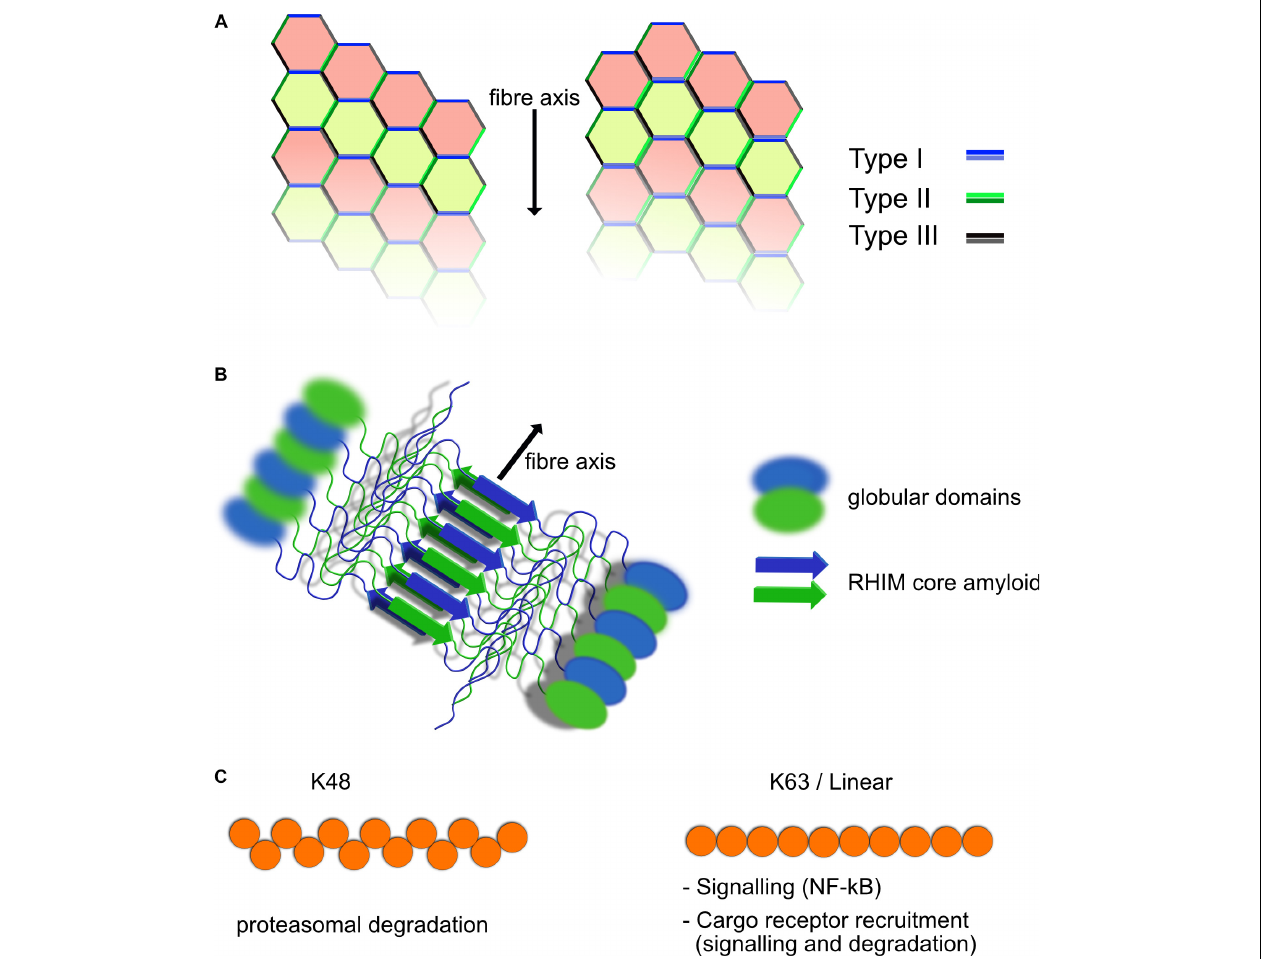
FIGURE 1 | Structural elements of death domain family, RHIM and ubiquitin scaffolds. (A) Death domain family interaction can form fibrillar structures. Death domain family members interact with themselves through three different interaction modes known as Types I–III, depending on the surfaces of the domain that interact. Shown are two possible helical fibrillar assemblies using differing combinations of interfaces. Multiple forms of this type of interaction have been identified, allowing for modular assembly of different complexes. (B) RHIM–RHIM scaffolds form amyloid fibrils. Shown is a fibril of two proteins containing a RHIM and globular domains. The fibril is formed by two parallel beta amyloid sheets coming together. This brings the globular domains into close proximity for interaction and potential activation such as kinase domains of RIPK1/3. RHIM fibrils can be mixed or homogeneous (RIPK1–RIPK3 or RIPK3–RIPK3 fibers form example). (C) Polyubiquitin chains have different functional roles. Shown are K48 and K63/linear ubiquitin chains. The structural layout of the individual chains is different resulting in recruitment of different ubiquitin binding proteins. K63 and linear ubiquitin chains are similar in their layout, although still functionally distinct. K48 chains are predominantly used for proteasomal degradation, whereas K63 and linear ubiquitin chains are used for recruitment of NF- κ B activating complexes such as TAB/TAK and IKK as well as linking to autophagic cargo receptors among other